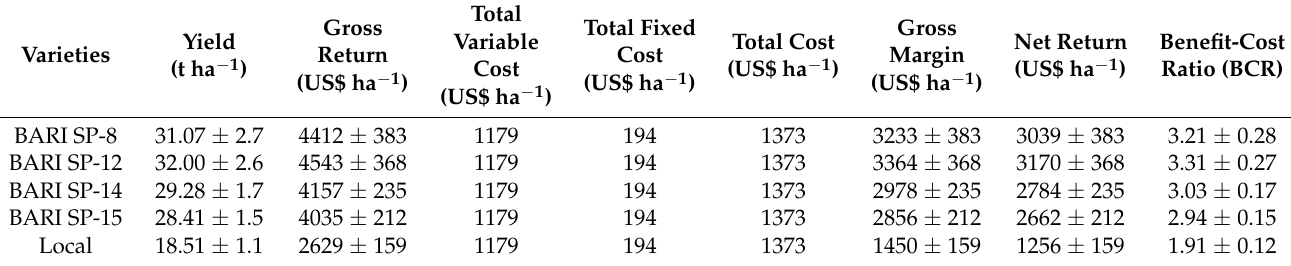
Table 12. Economic profitability of OFSP. Data are presented mean ± standard error in US$ (1 US$ = 84.69 BDT).